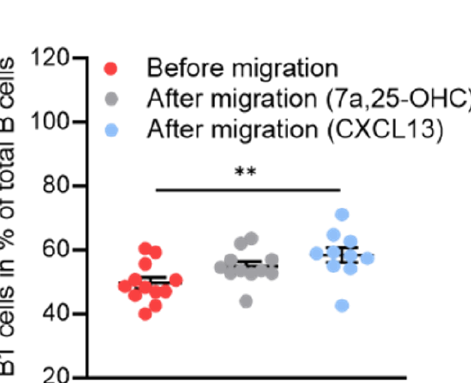
Figure 1. GPR183 expression in and 7α,25-OHC-directed migration of peritoneal cavity B cell subsets; ( A ) gating scheme used to sort peritoneal cavity cells into B1a (B220 low/÷ CD5 + ), B1b (B220 low/÷ CD5 ÷ ), and B2 (B220 + CD5 ÷ ) cell subsets. Cells were gated on lymphocytes; ( B ) qPCR analysis of GPR183 mRNA levels relative to the control gene YWHAZ in the indicated B cell subsets sorted from peritoneal cavity cells by FACS, as shown in ( A ). Error bars represent mean ± SEM of data from 5 15–16 weeks old WT mice; ( C ) quantification of cells that migrated in vitro in response to varying concentrations of 7α,25-OHC, as indicated. Identification and quantification of the cells was performed after migration by flow cytometry. Cell counts were normalized to the average highest and lowest values in each dataset; ( D ) frequencies of B1 cells before migration and after migration in response to 10 − 7 M 7 α ,25-OHC or 10 − 7 M CXCL13. Error bars in ( C , D ) represent mean ± SEM